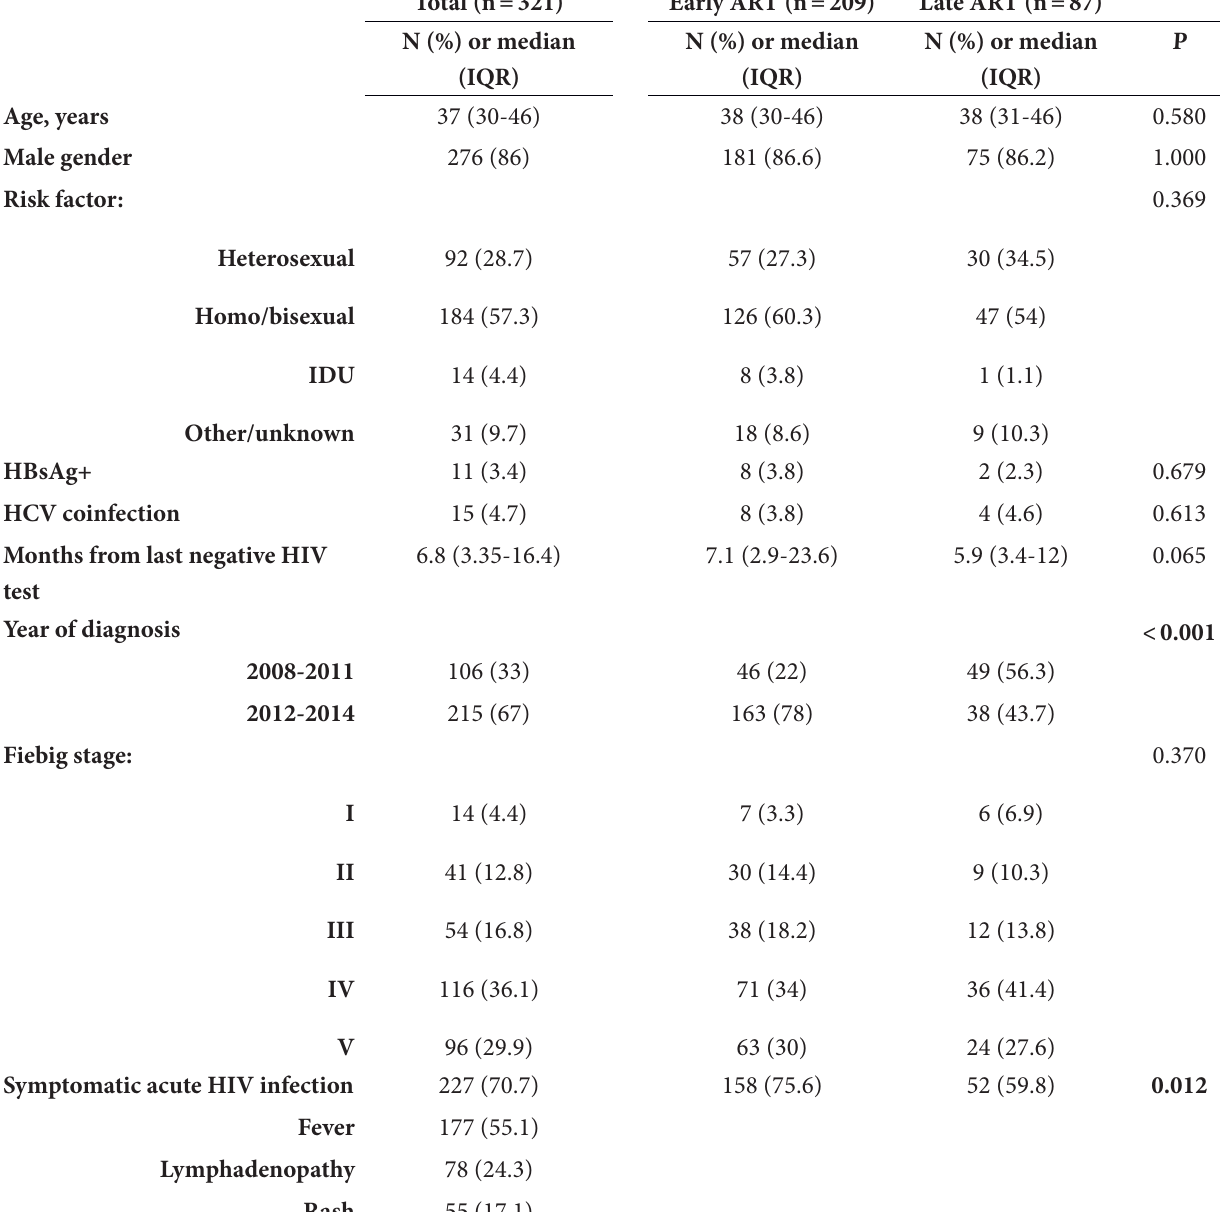
Table 1. Population characteristics at the time of AHI diagnosis (n = 321) and comparison of Early (< 3 months from AHI diagnosis) and Late (> 3 months) ART initiation groups (n =